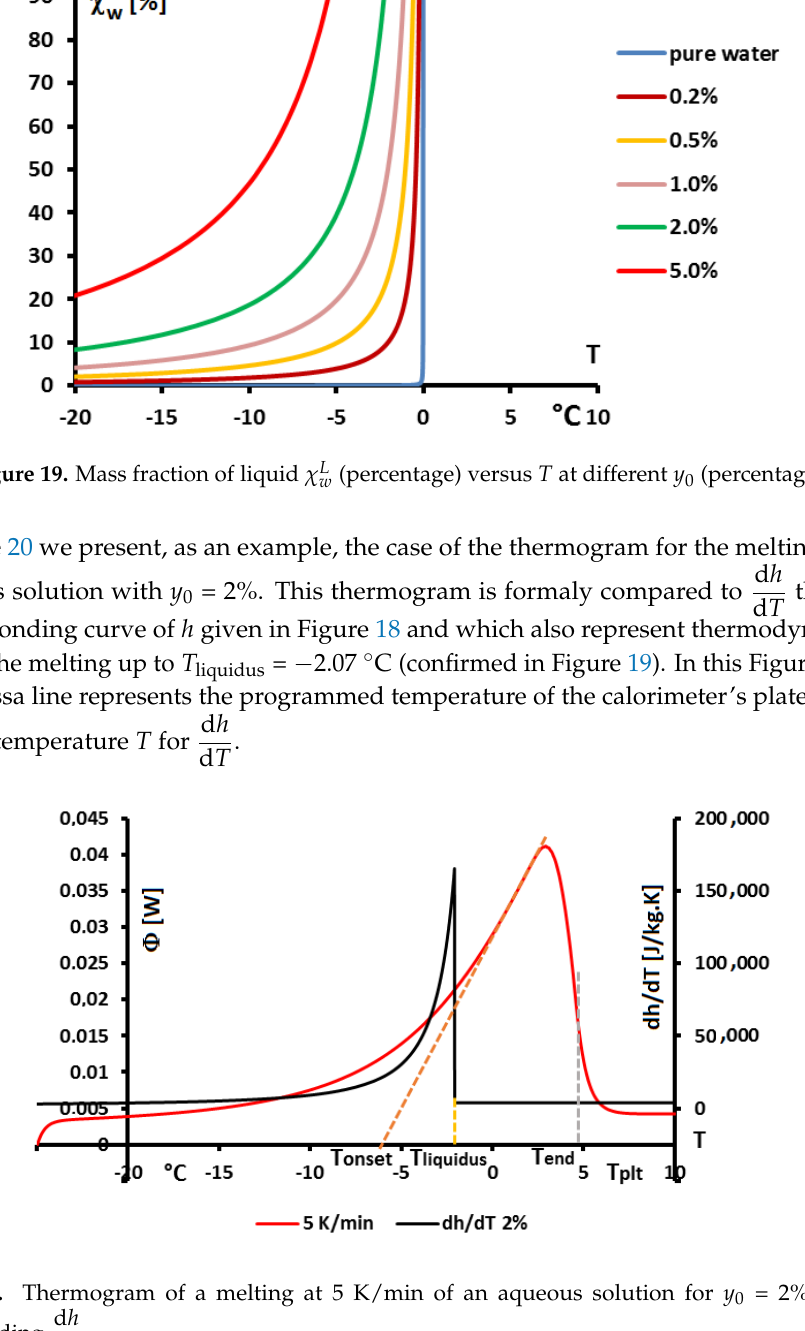
Figure 20. Thermogram of a melting at 5 K/min of an aqueous solution for y 0 = 2% and the d h corresponding d T